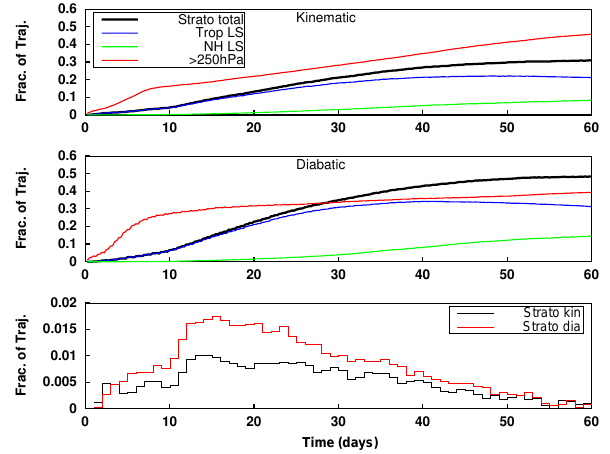
Figure 10. Fraction of trajectories located in the stratosphere (black), the tropical stratosphere only (blue), the northern extrat- ropical stratosphere (green) and below 250hPa (red) as a function of time for kinematic (top panel) and diabatic (middle panel) trans- port. Bottom panel: transit time distribution to the